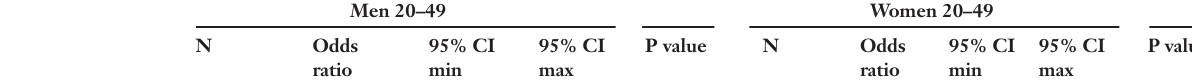
Bivariate associations of decrease in sexual desire with the principal independent variable and other